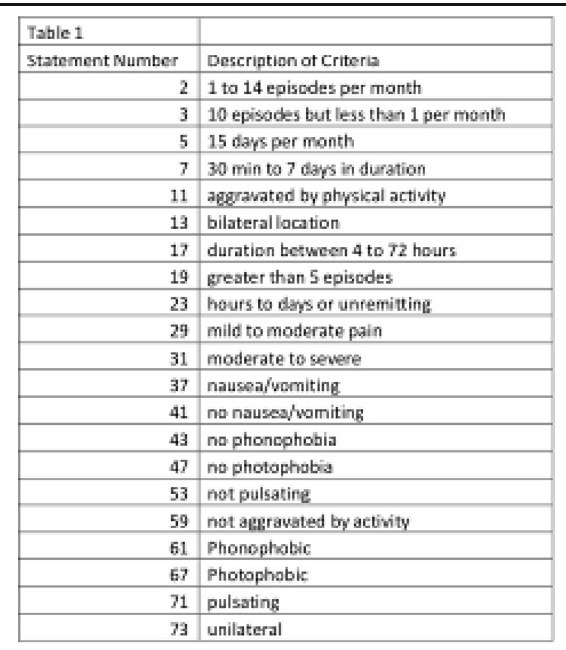
Table 1 (abstract P199). See text for